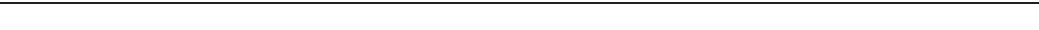
Fig. 24. Fruits of Icacinaceae Miers. 1 – 9 . Pyrenacantha andapensis Labat, El-Achkar & R.Rabev. ( D. Ravelonarivo et al. 72 ). 1 . Dried fruit with an elongate gynophore here boken, lateral view. 2 – 6 . Broken endocarp. 2 . Lateral view showing the pits. 3 . Dorsal view. 4 . Opposite lateral view. 5 . Apical view. 6 . Basal view. 7 . SEM image of the endocarp wall with spiny tubercles in transverse section. 8 . SEM image of cells in the inner part of the endocarp wall in transverse section and the innermost layer that line the locule with papillae. 9 . SEM image of the small ovoid hairs with an acuminate apex on